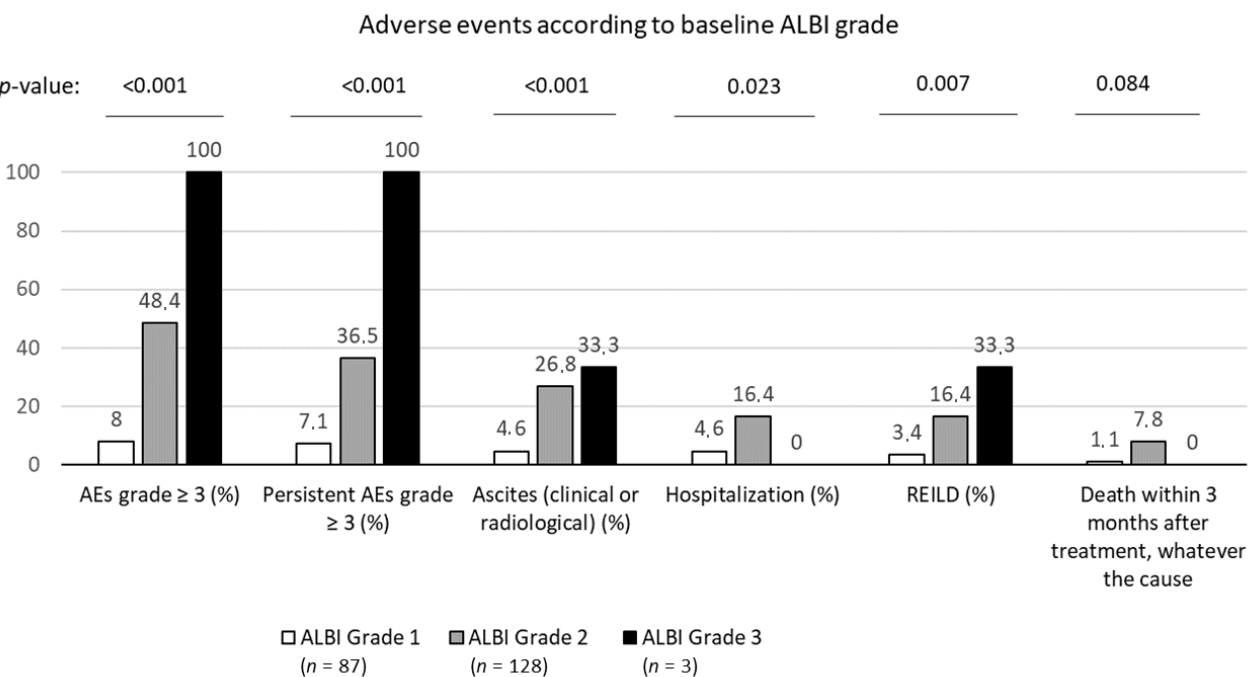
Figure 2. Occurrence of main toxicities, according to baseline ALBI grade. AEs: adverse events; REILD: radioembolization- induced liver disease. p -values were calculated by Chi-square test for trend.